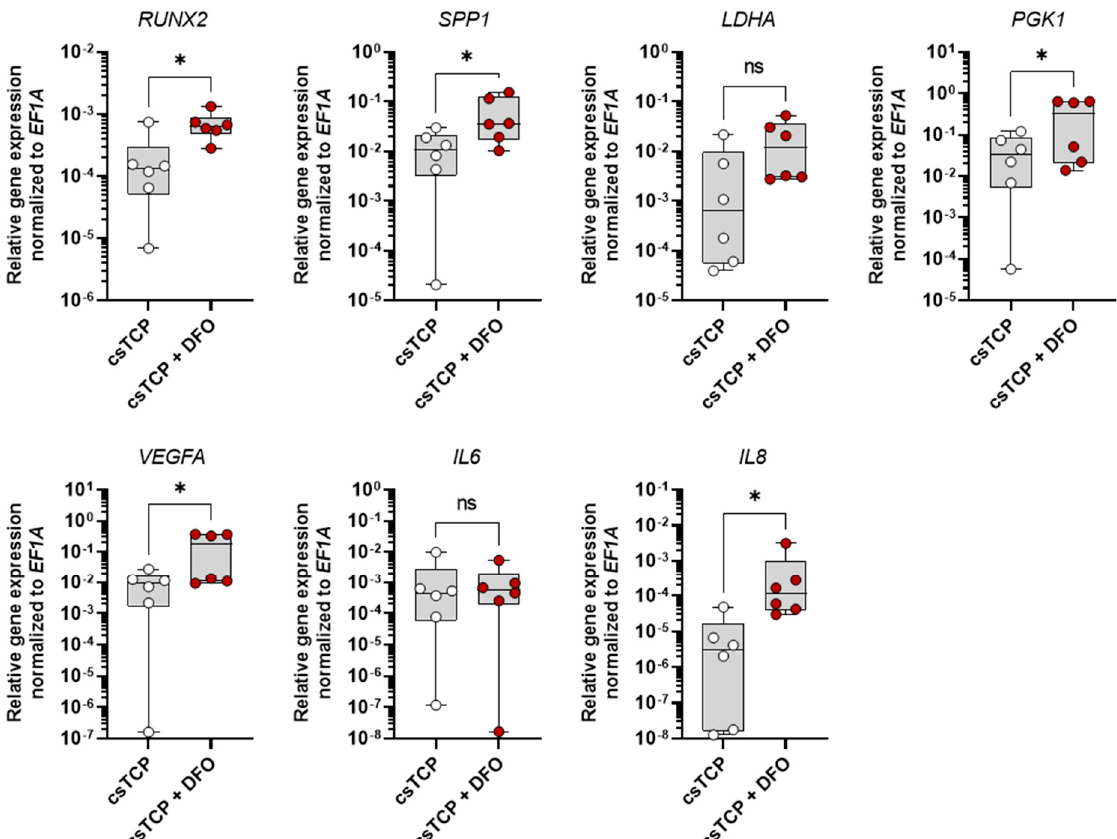
Figure 5. Deferoxamine (DFO) conditioned medium further promotes osteogenesis of the csTCP bone model verified on mRNA level using RT-qPCR. csTCP was treated after 21 days with 250 µ M DFO for 72 h. Relative expression of RUNX2 , SPP1 , LDHA , PGK1 , VEGFA , IL6 , and IL8 was normalized to the housekeeper gene EF1A . Data are shown as box plots (centerline, median; box limits, upper and lower quartiles; whiskers, maximum and minimum values; all data points); n = 6. Statistics: Two-tailed Wilcoxon matched-pairs signed-rank test. p -values are indicated in the graphs with * p < 0.05 and ns = not significant.